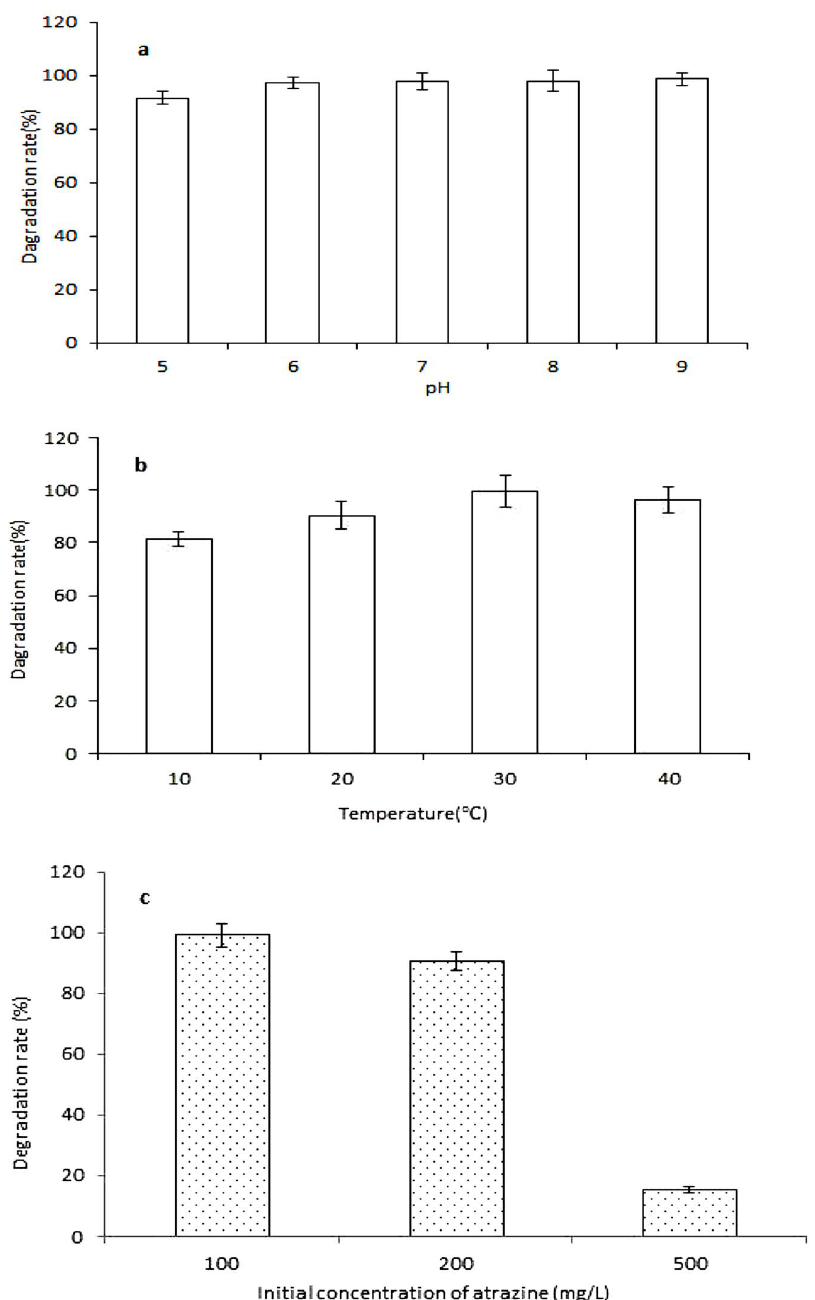
Figure 2. Degradation of atrazine by strain HB-6 at different culture conditions. Different pH values (a), temperatures (b) and initial concentration of atrazine (c). Error bars represent the standard deviation of three